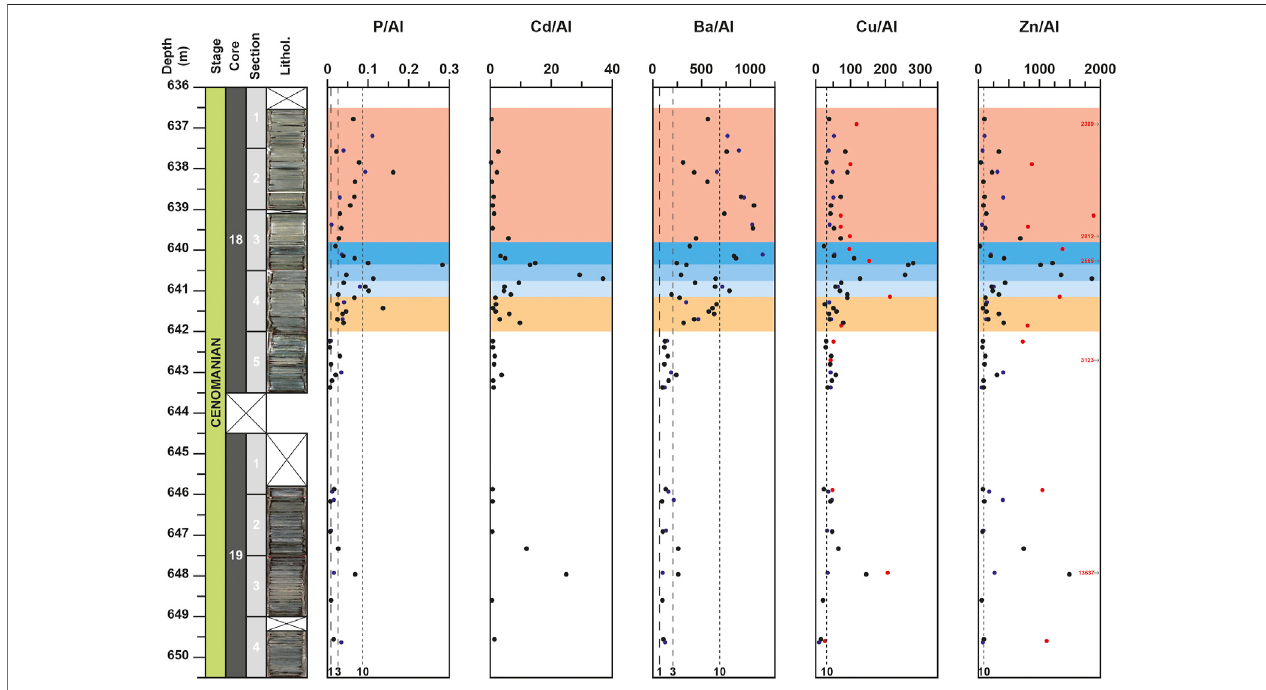
FIGURE 5 | Depth-pro fi les for P/Al, Cd/Al, Ba/Al, Cu/Al, Zn/Al for the DSDP site 367. Data from the studies of Kuypers et al. (2002), coupled to unpublished data from H-J. Brumsack on the same samples, and Westermann et al. (2014) are represented with blue and red circles respectively. Vertical black dotted lines, noted 1, 3 and 10, represent the El/Al value corresponding to an EF equal to 1, 3 and 10, respectively compared to the Upper Continental Crust (McLennan, 2001): 0.087 for P/Al; 0.01 for Cd/Al; 68.41 for Ba/Al; 3.11 for Cu/Al and 8.83 for Zn/Al.